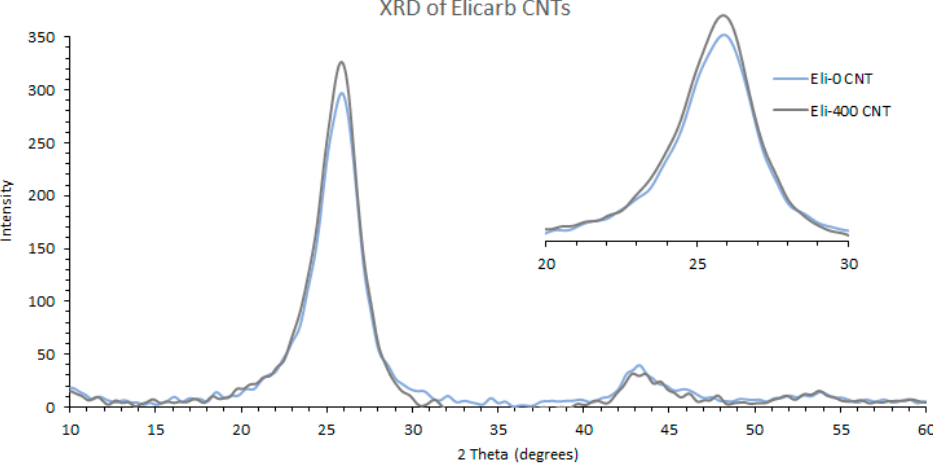
Figure 4. XRD spectrums of unmilled and milled Elicarb CNTs.